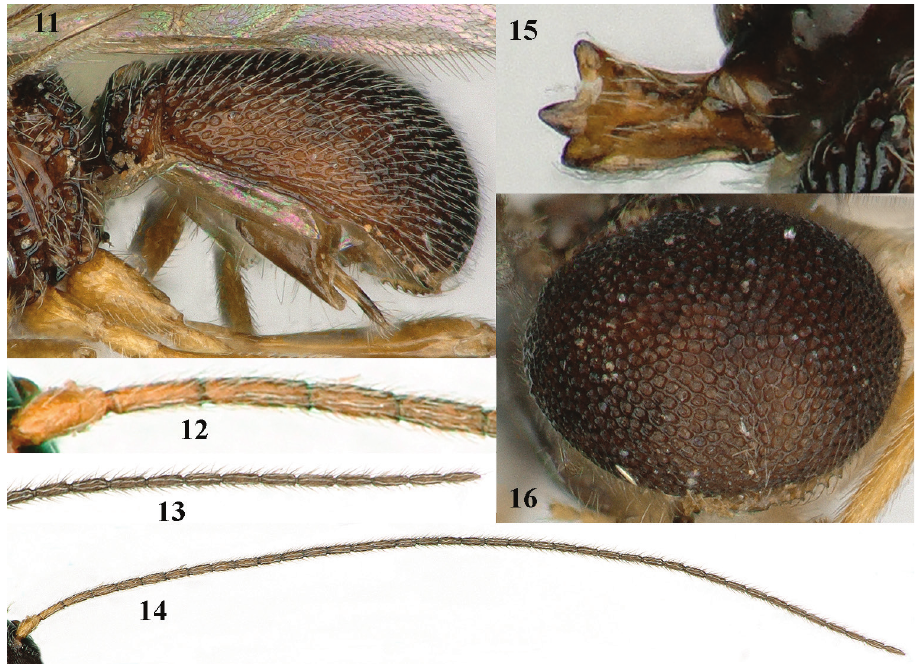
Figures 11–16. Gastralysia garambana Fischer, ♀ , Ivory Coast. 11 metasoma lateral aspect 12 basal seg- ments of antenna 13 apical segments of antenna 14 antenna 15 mandible, full on first tooth lateral aspect 16 metasoma posterior